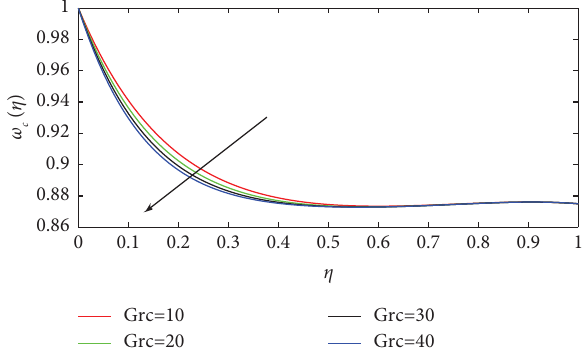
Figure 19: Concentration profles for the diferent values of Grc.